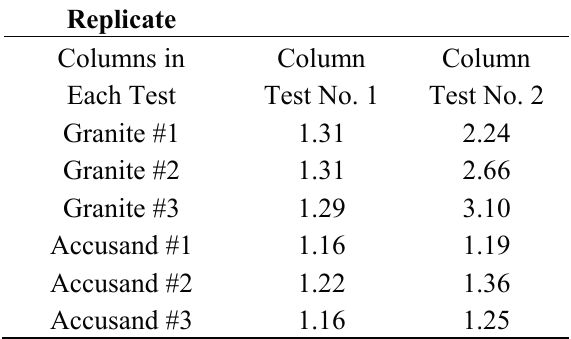
Figure 3. Sieve analysis of backwashed Accusand and granite media from Column Test No. 2. Table 5. Morrill Dispersion Index (MDI) for tracer tests conducted prior to Column Tests No. 1 and No. 2. MDI of 1.0 corresponds to perfect plug flow; <2.0 is effective plug flow according to EPA (1996).